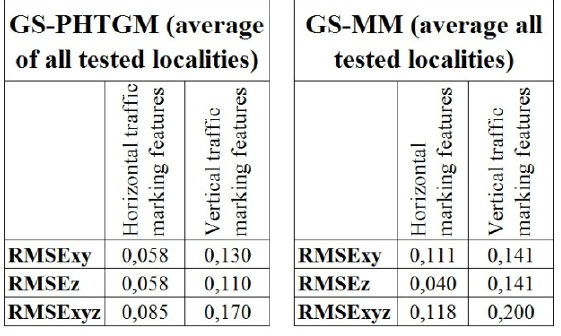
Table 1. Comparison mapping